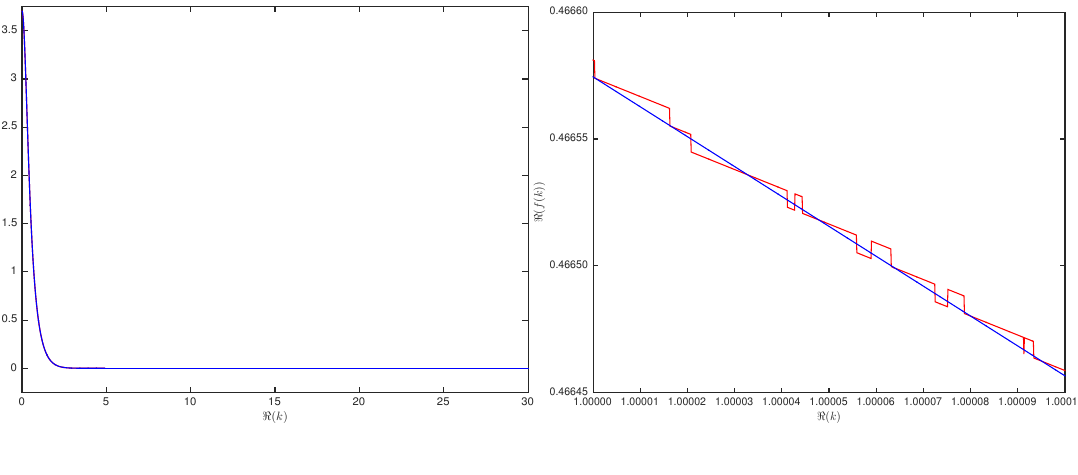
Fig. 1. Global and local view to the integrand f.k/ in (16) . The inaccurately enumerated values were obtained using double precision arithmetic (plotted in red), the smooth values are in vpa (blue). < .z/ denotes the real part of the complex variable z